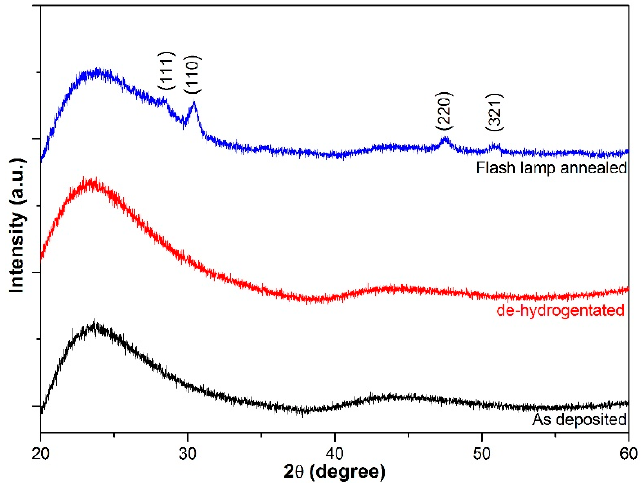
Figure 7. X-ray diffraction patterns of PECVD silicon thin films: as-deposited, de-hydrogenated, and flash lamp annealed. The vertical axis was plotted with y -offset for comparison.